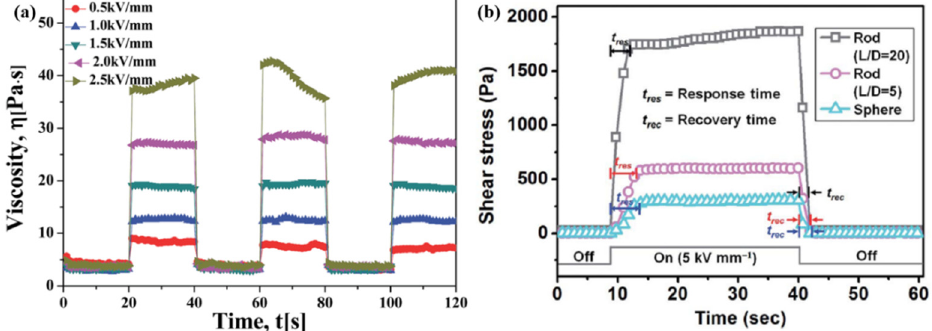
Figure 12. Effect of switching the applied electric field for ( a ) GO-coated silica based ER fluid (15 wt.%) [68] , ( b ) series of ER fluids based on GO-coated silica with different aspect ratios [60] .